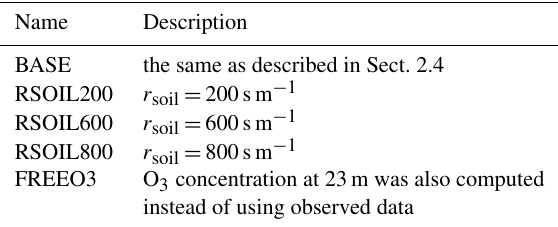
Table 1. Table of sensitivity cases. The case names and their short description texts are